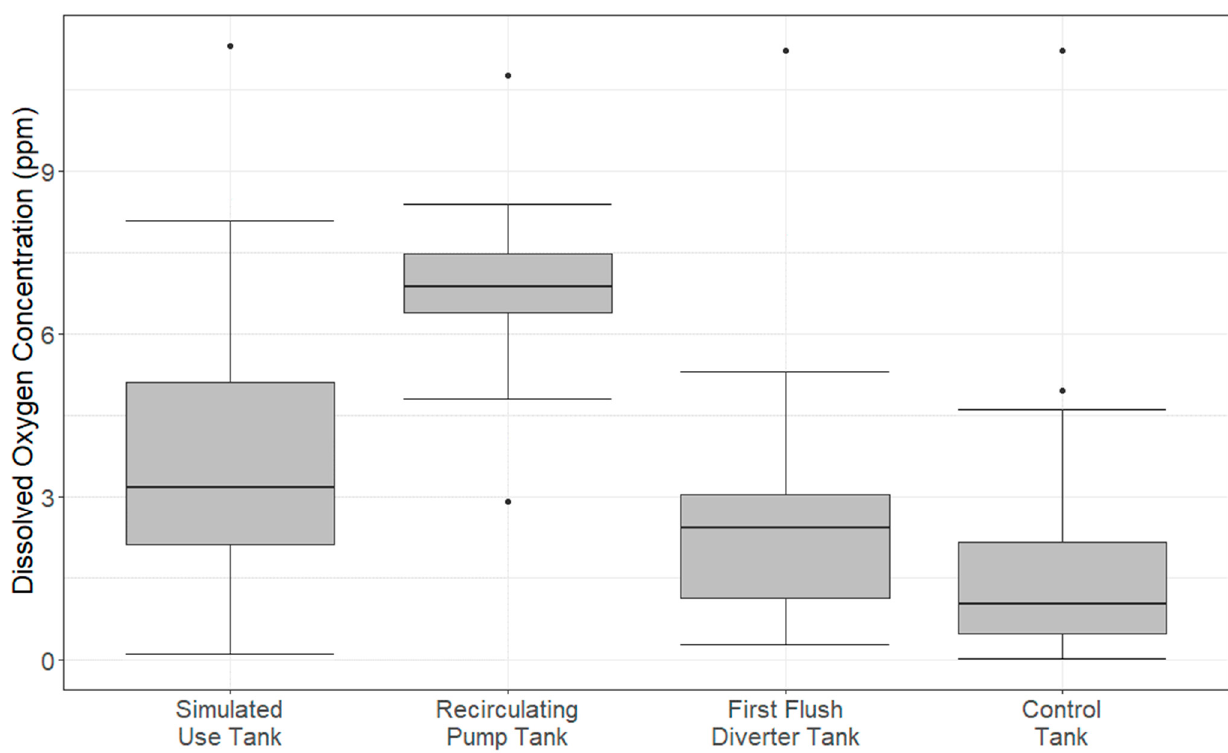
Figure 3. Average dissolved oxygen (DO) concentrations for each rainwater harvesting tank. Black dots represent outliers (defined as values greater than or less than 1.5 * inner quartile range).